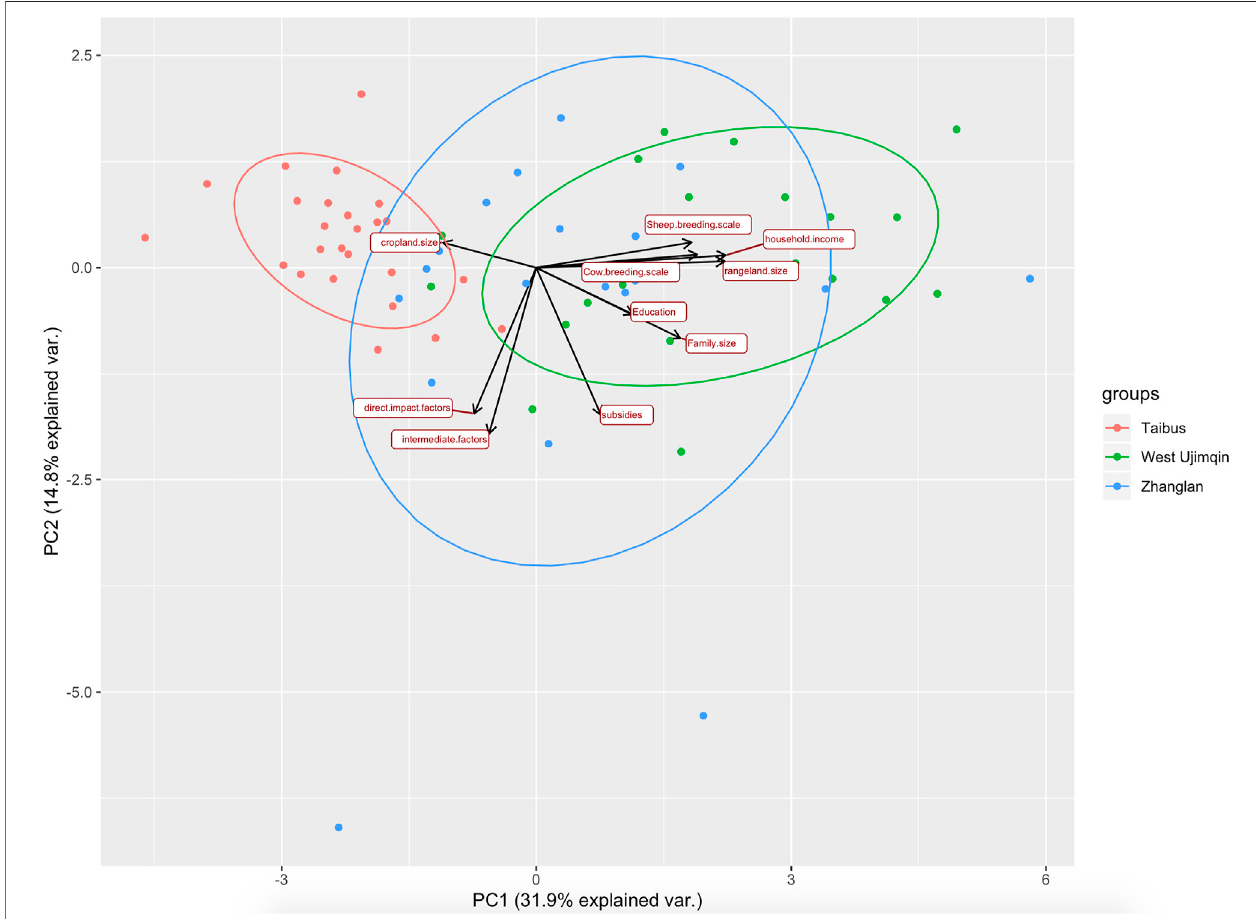
FIGURE 4 | Rotated PCA of all (marginally) signi fi cant results from fuzzy cognitive map (FCM) indicators, household eco-social indicators, and personal characteristic indicators.